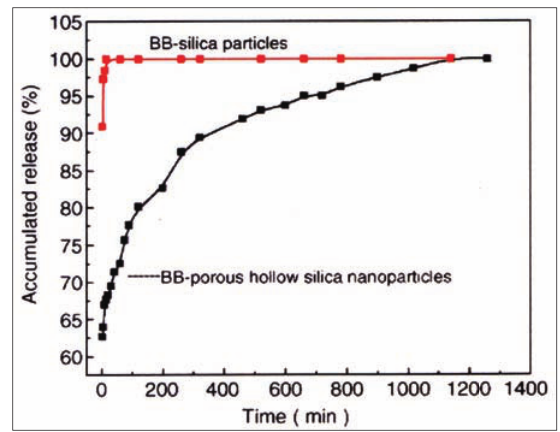
Fig. 14 Release profile of BB form hollow SiO 292)